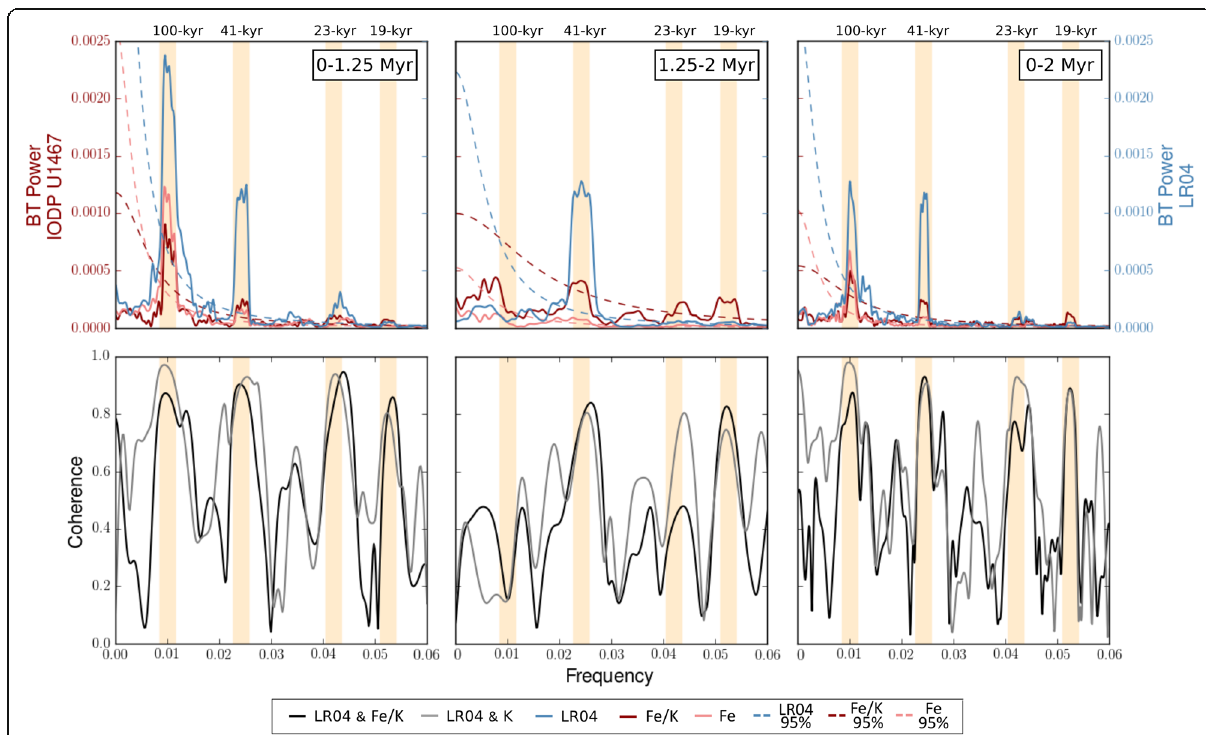
Fig. 10 Spectral analysis results using the Fe intensity (light red), Fe/K (dark red) and LR04 benthic stable oxygen isotope stack (blue) records. Also, coherences between Fe intensity and LR04 (grey) and Fe/K and LR04 (black) are shown. Dashed lines indicate 95% confidence levels (see